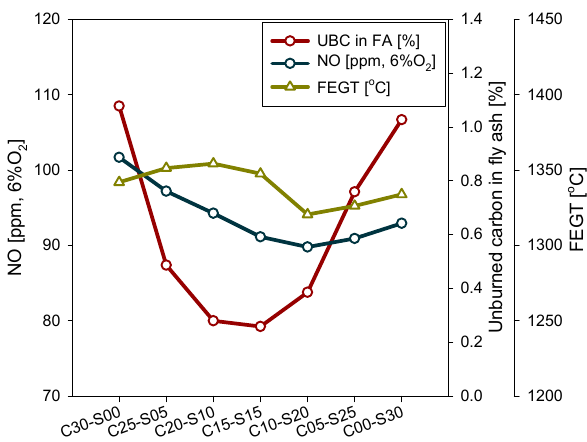
Figure 14. Comparison of NOx emission, UBC in fly ash, and FEGT for different CCOFA/SOFA distributions (total OFA ratio fixed at 30%).